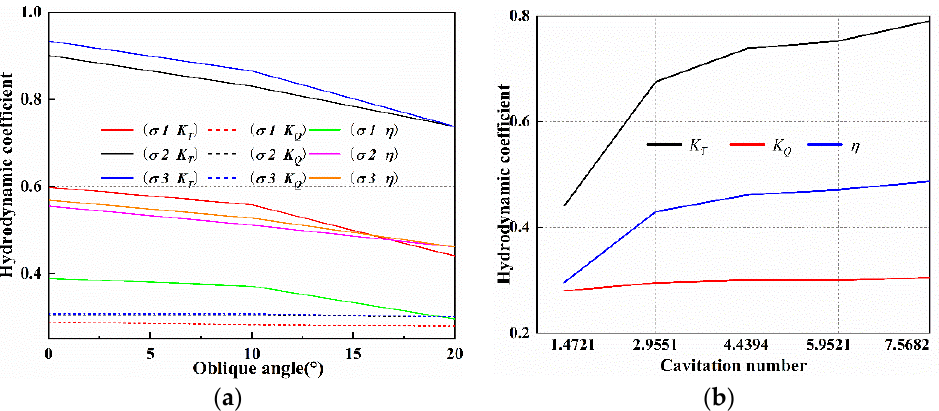
Table 10. Difference at different oblique angles.